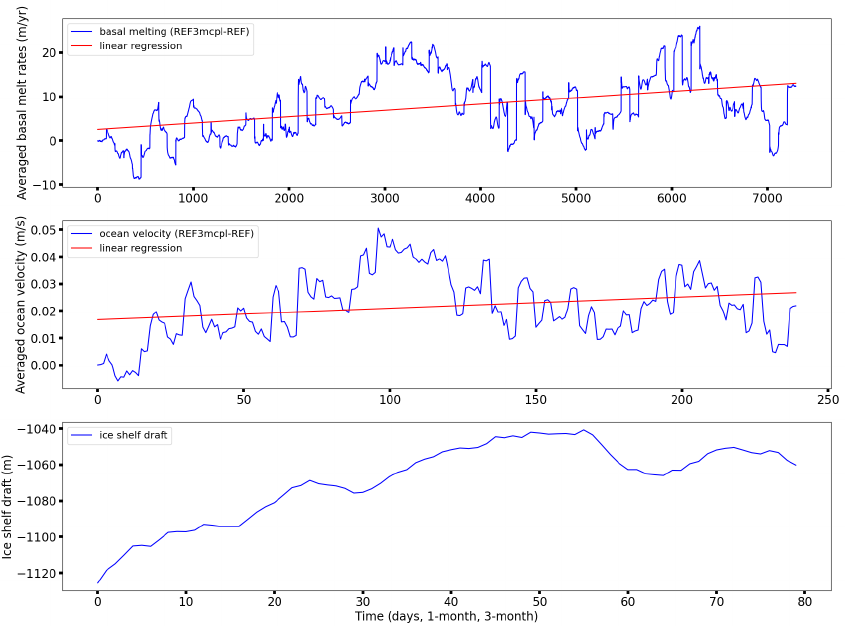
Figure A5. Time series of the difference in basal melt rate, ocean current speed and ice shelf draft over the 20-year period in REF and REF3mcpl. All time series are averaged only where the mean basal melt rate is higher than 50 m year − 1 .